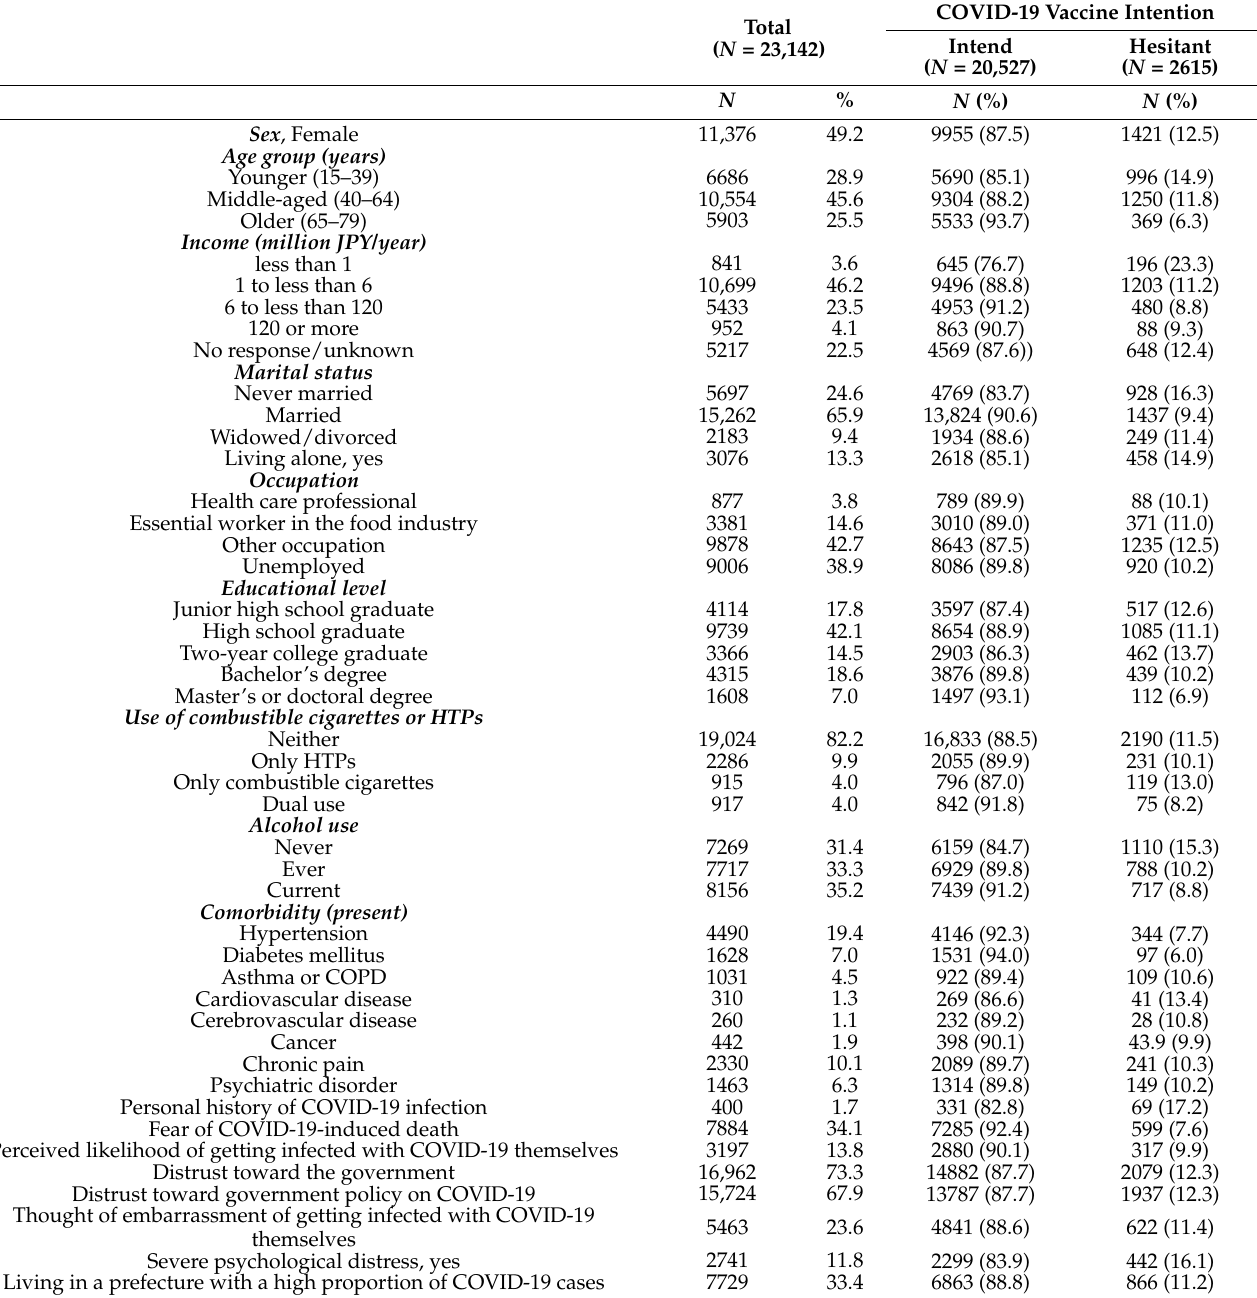
Table 1. Participants’ baseline characteristics included in